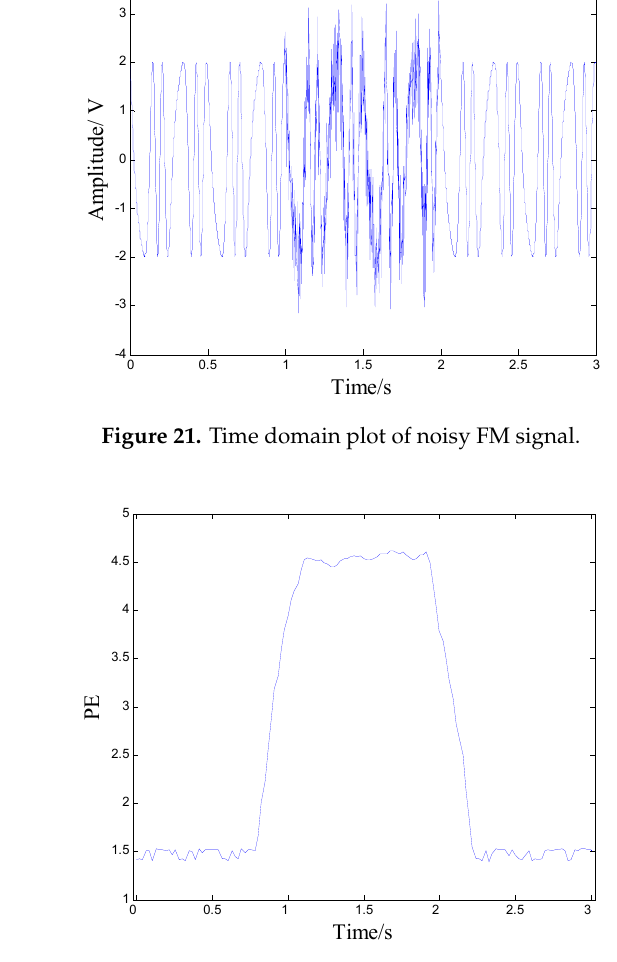
Figure 21. Time domain plot of noisy FM signal.